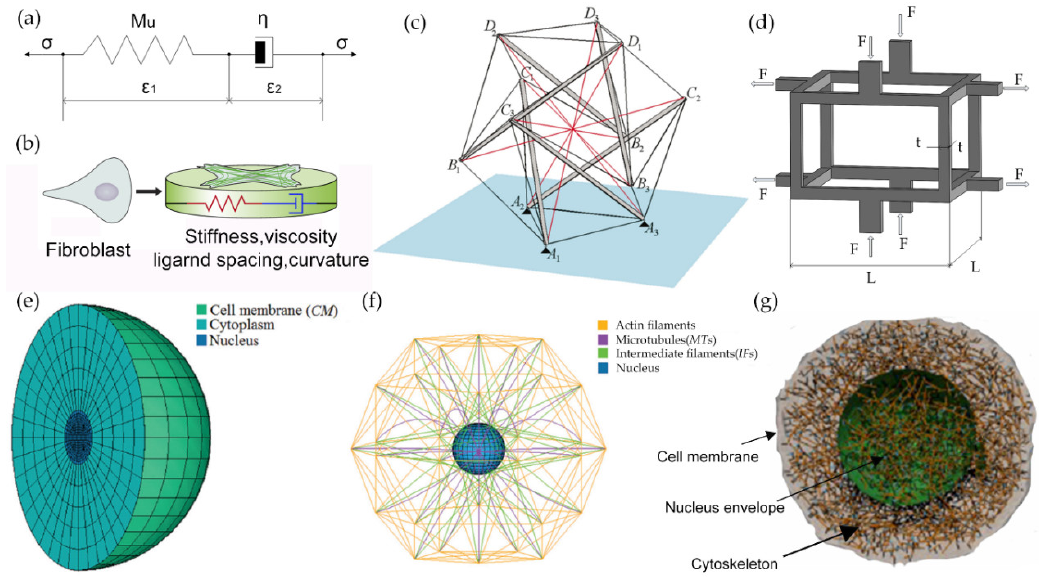
Figure 1. Cell mechanics model. ( a ) Maxwell model; ( b ) elastic model of fibroblasts (adapted by kind permission from [18]); ( c ) tensegrity mathematical model (adapted by kind permission of [30]); ( d ) foam model; ( e ) suspension cell mechanical model, continuum part (adapted by kind permission of [42]); ( f ) suspension cell mechanical model, cytoskeleton component (adapted by kind permission of [42]); ( g ) krill dynamics model (adapted by kind permission from [45]).